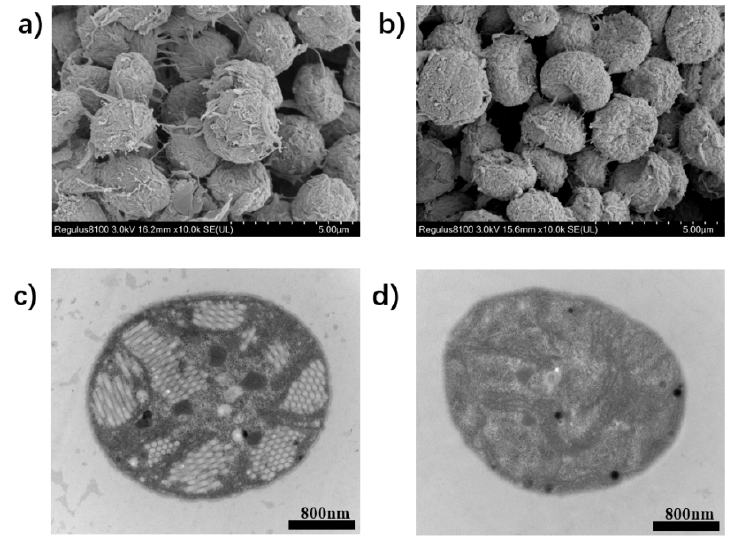
Figure 8 . ( a – d ) SEM pictures of Microcystis aeruginosa cell ( a ) before and ( b ) after ST; TEM pictures of Microcystis aeruginosa cell ( c ) before and ( d ) after ST.